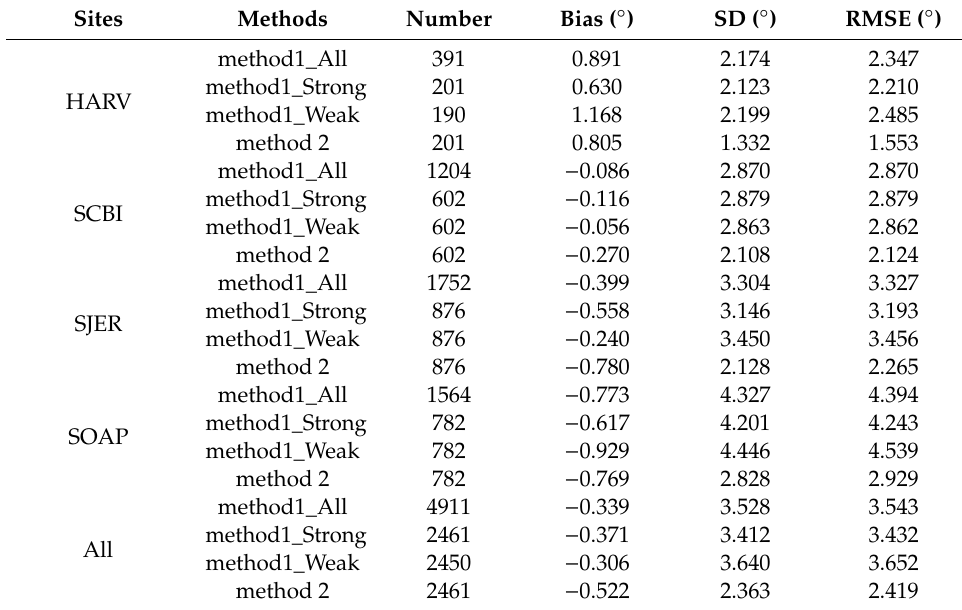
Table 2. The statistical slope errors using di ff erent methods across various experimental sites.